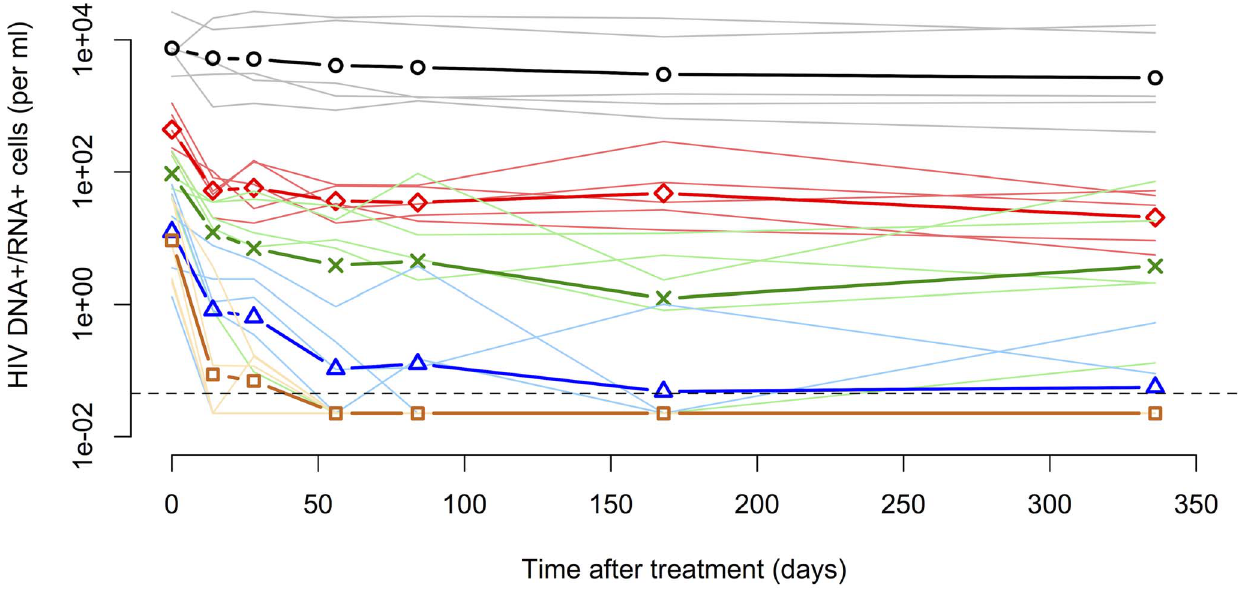
Figure 2. Decay kinetics of subclasses of HIV-1-infected cells during cART. The five subclasses of PBMCs are: DNA z (containing HIV-1 DNA, black circles), Low (containing solely HIV-1 UsRNA, red diamonds), Mid (containing only HIV-1 MsRNA-tatrev or MsRNA-nef, green crosses), High (containing elevated levels of both HIV-1 MsRNA-tatrev and MsRNA-nef, blue triangles) and Extra (carrying virion-enclosed HIV-1 RNA, chocolate squares). Thick lines and symbols represent the geometric means of the five patients from the study by Fischer et al. [12]. Thin transparent lines for each color represent the original data for each subclass of cells of each individual patient. The dashed line represents the limit of detection that was set at 50% of the lowest measured cell count. Measurements below this threshold were assumed to be at 50% of the detection limit to include them in the mean.